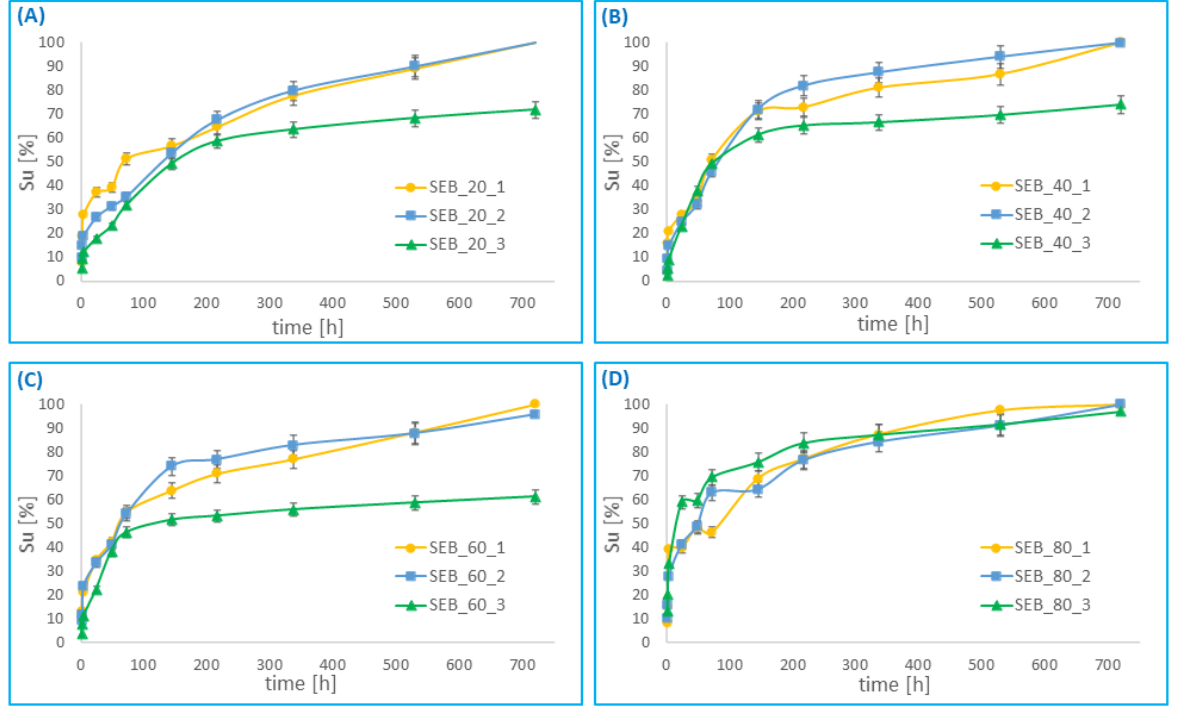
Figure 11. Cumulative release of rifampicin from large microspheres, obtained from: DBB_SEB_20 ( A ), DBB_SEB_40 ( B ), DBB_SEB_60 ( C ) and DBB_SEB_80 ( D ), as a function of time.